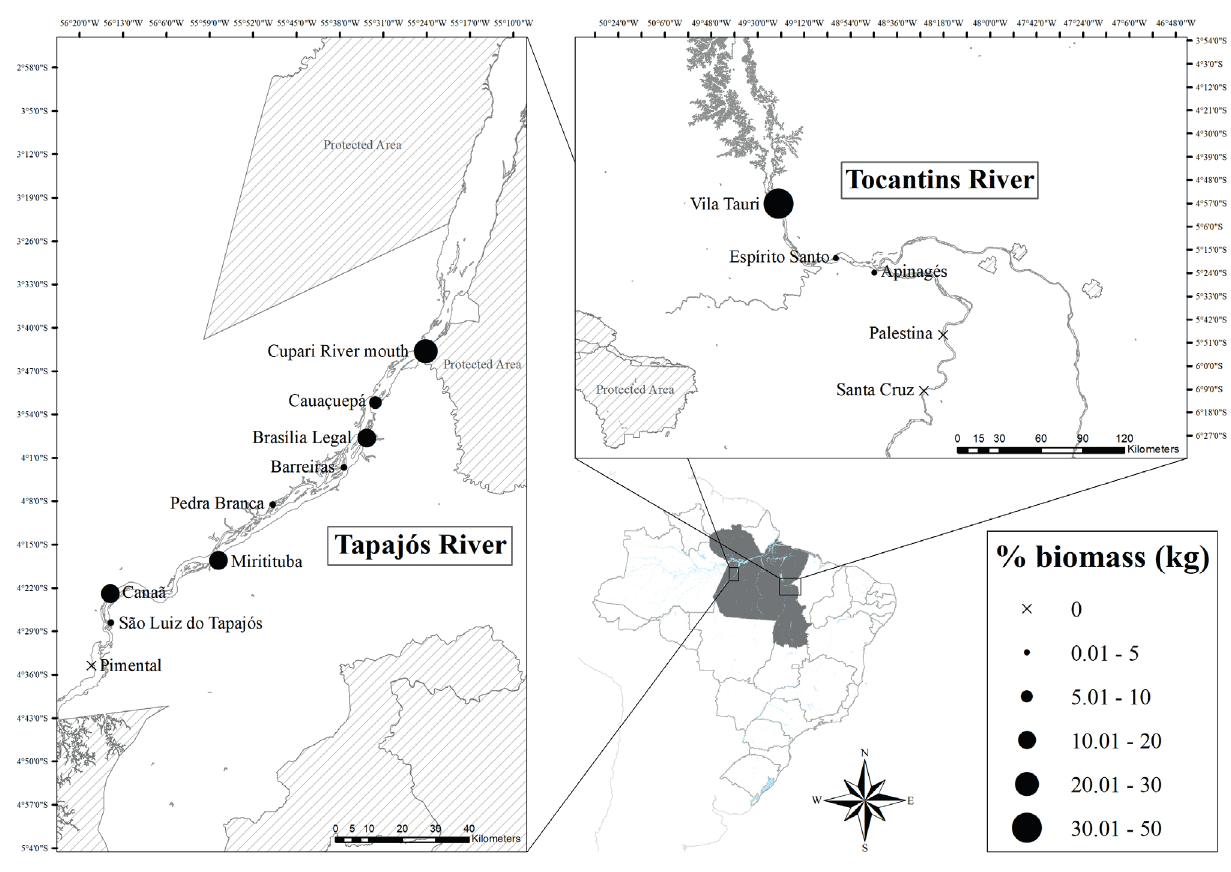
FIGURE 1 | Map of the studied region in the middle course of the Tapajós, Tocantins-Araguaia rivers, in the Brazilian Amazon, showing the fishing communities and distribution of biomass of Plagioscion squamosissimus (black circle) sampled where the research (fish sampling and interviews) was